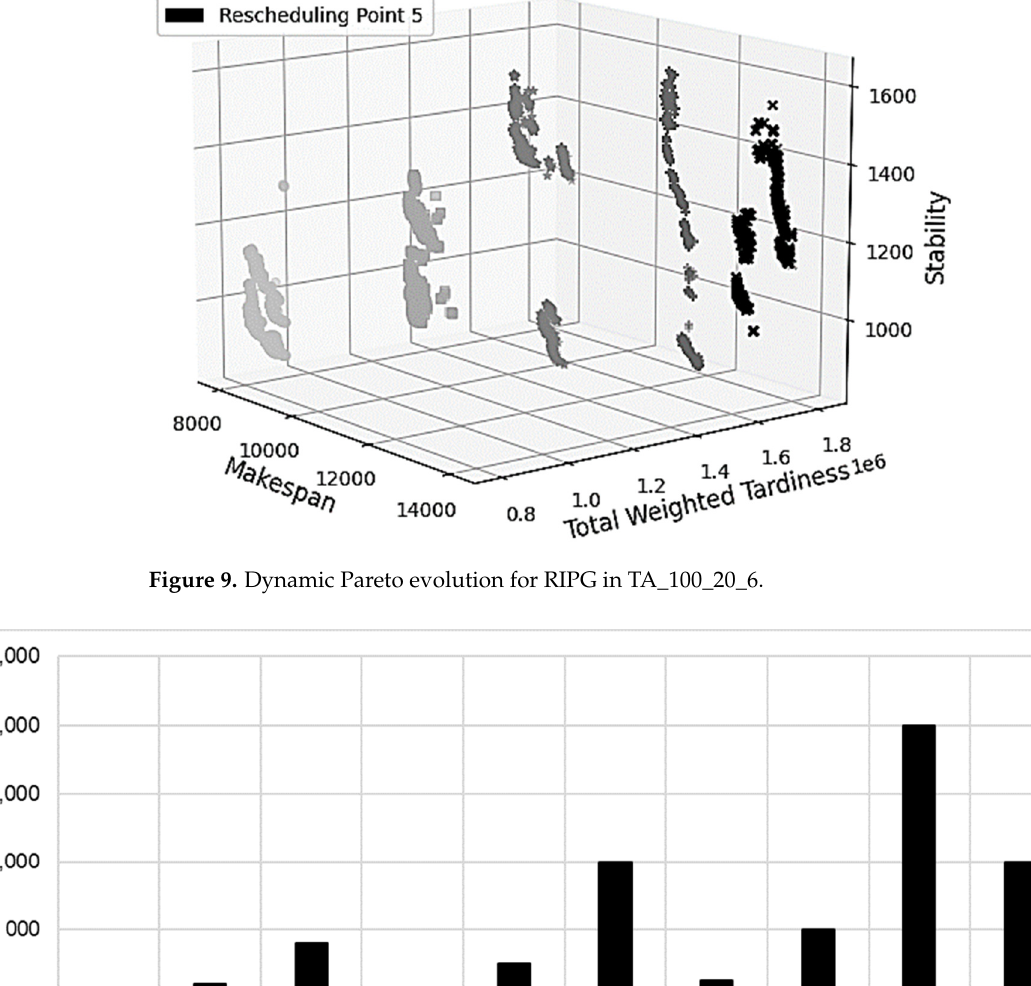
Figure 10. Total execution times on every rescheduling instance for each metaheuristic.